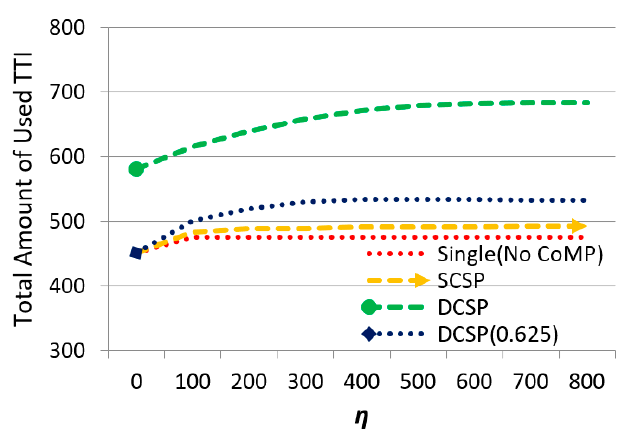
Figure 9. The effect of η on the total amount of used TTI. Figure 8. The effect of η on average cluster size.